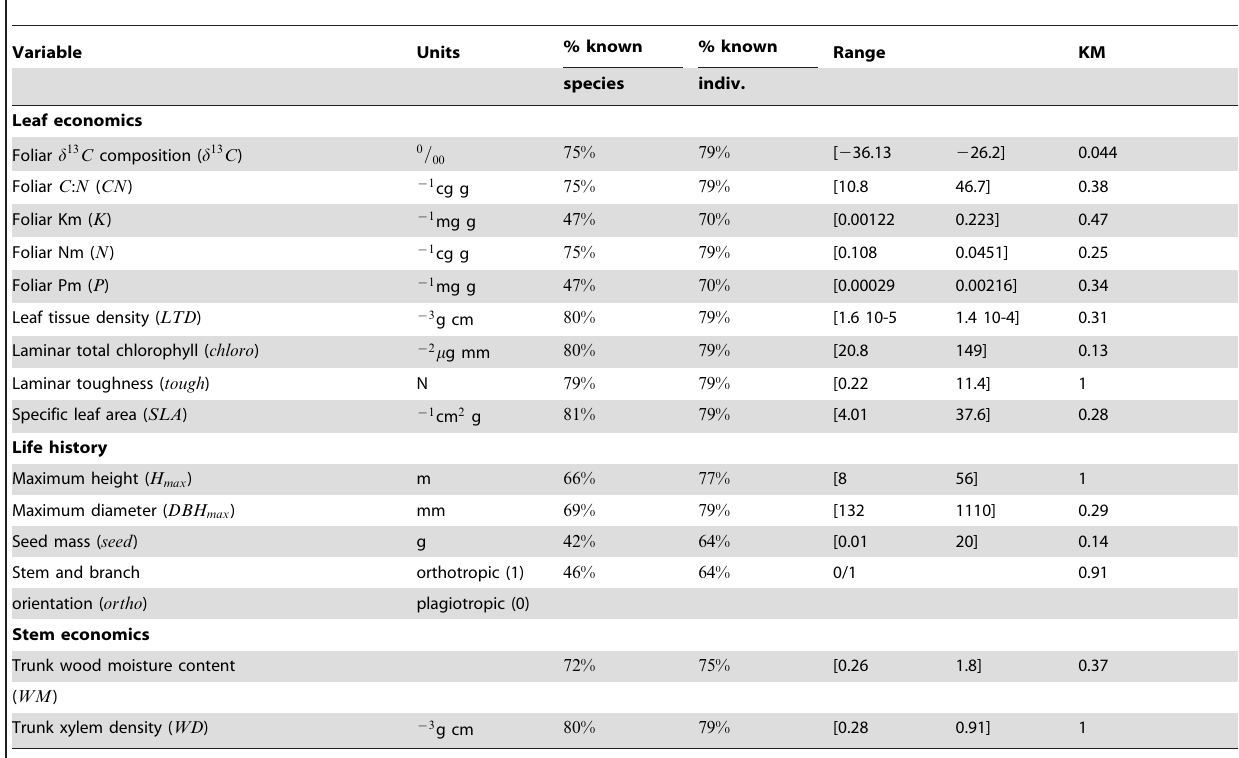
Table 1. The 15 functional traits used in the study: variable names, units, % of species for which the value of this trait is known in our data set, % of individuals for which the value of this trait is known in our data set, range of the value and results of the Kuo- Mallick (KM) algorithm for variable